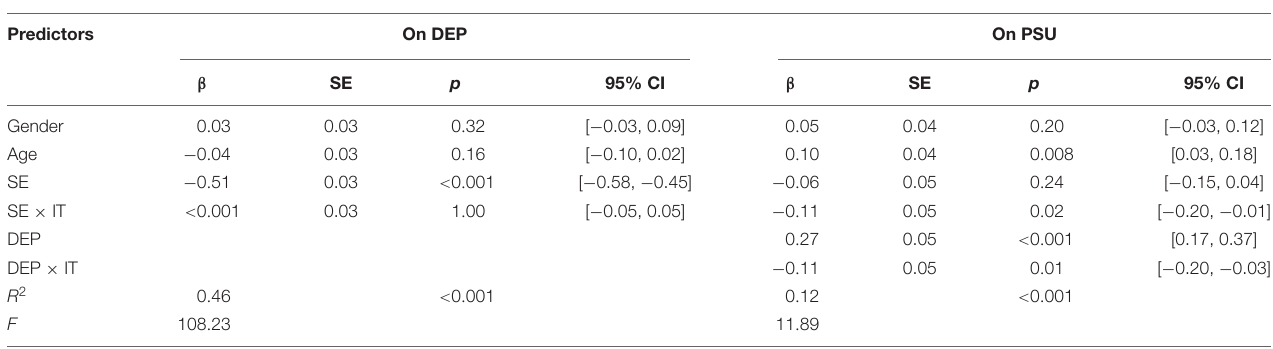
TABLE 3 | Testing the moderated mediating effect of self-esteem on PSU. Predictors On DEP